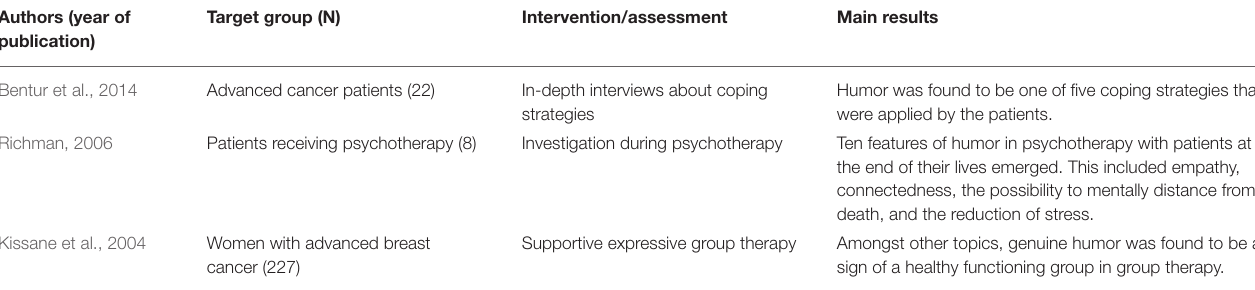
TABLE 4 | Studies with patients in other care